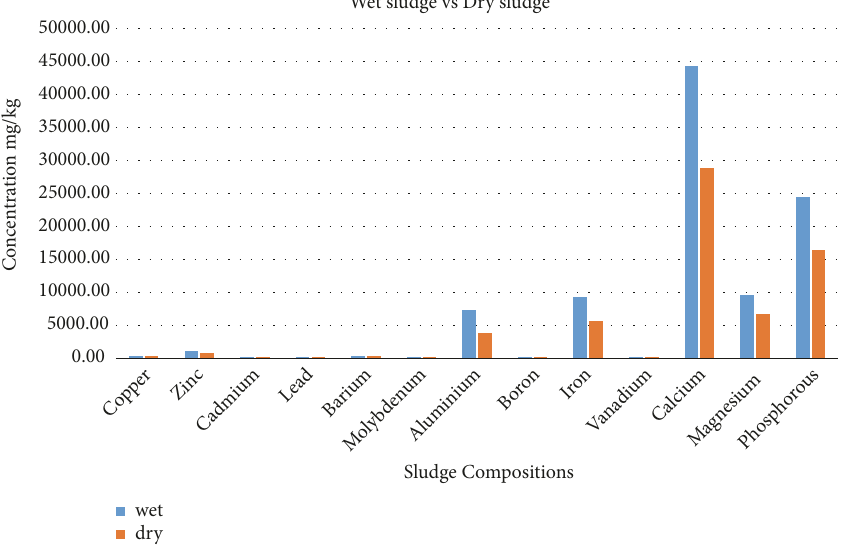
Figure 1: A graph of sludge composition having higher concentrations in wet sludge than dry